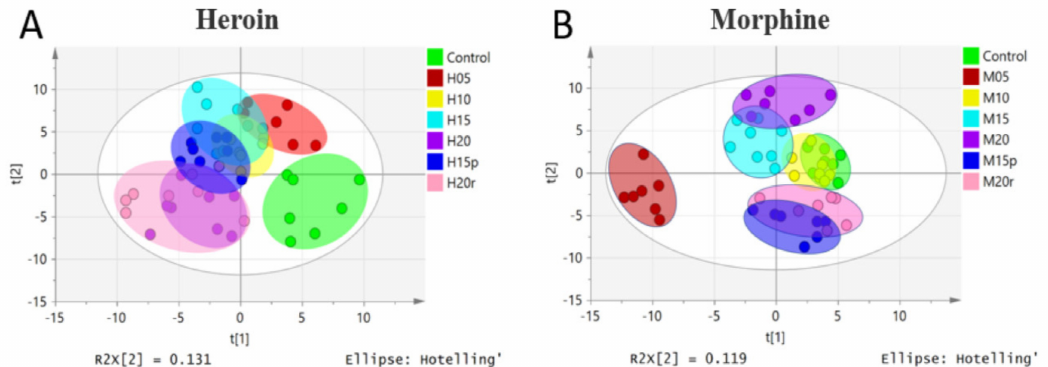
Figure 1. PLS-DA model of metabolic patterns for mouse serum. ( A ) Serum data from heroin-treated mice. Heroin was administered for 5 days (H05, red dots), 10 days (H10, yellow dots), 15 days (H15, light-blue dots), and 20 days (H20, purple dots). Mice were subjected to withdrawal (H15p, blue dots, withdrawal for 5 days after 10 days of heroin administration) and re-administration (H20r, pink dots); the control group is shown as green dots. ( B ) Serum data from morphine-treated mice. Morphine groups are labeled in the same way as heroin